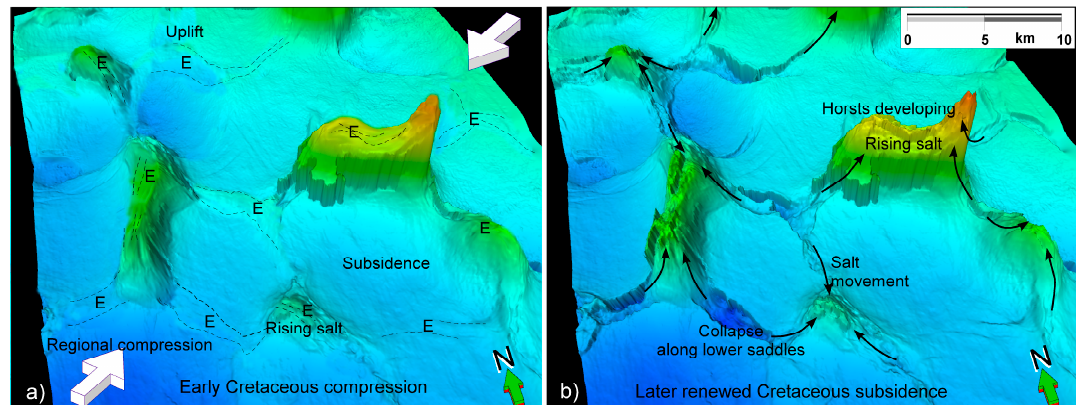
Figure 8. a ) Effect of Early Cretaceous compression from SW on an unfaulted surface. Blue arrows indicate areas with increased subsidence, red arrows show areas with increased uplift. In the saddle areas between basins and over the highest salt structures extensional faults will occur, as indicated by the stippled lines and marked by E. The background figure is based on the BCU surface and is manipulated in a photo editor to mimic a smoother pre-faulting surface. b ) Effect of renewed subsidence. Collapse grabens (most prominent along the WNW-ESE trend) have developed along the salt saddles. Horsts are developed on the highest salt structures. Background figure is an unedited BCU surface interpreted by LOTOS.